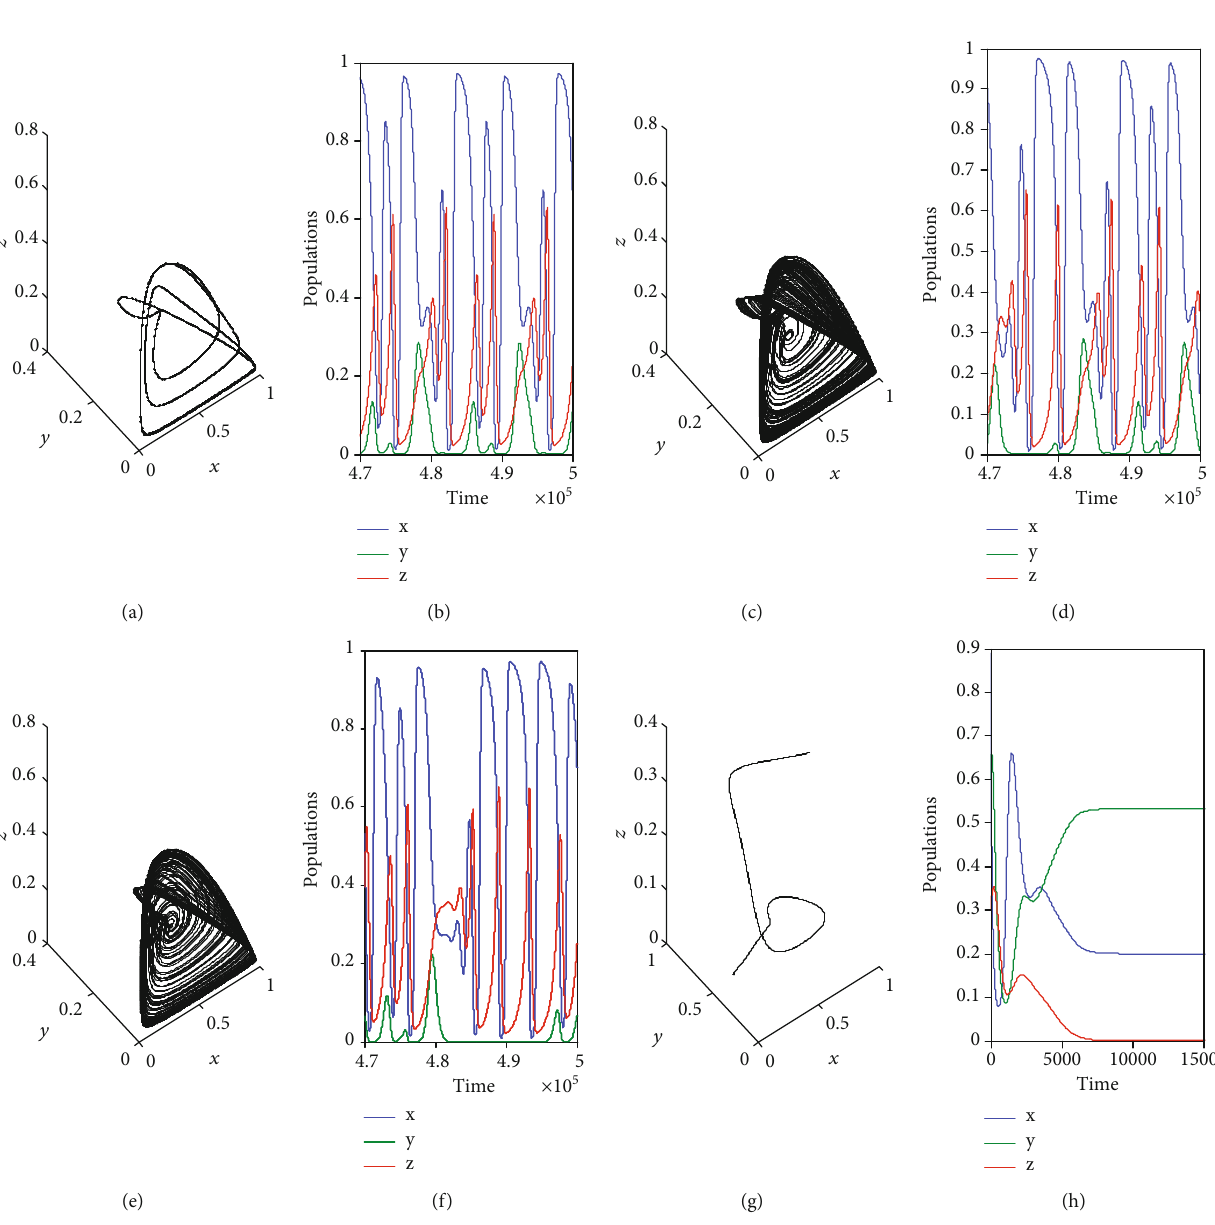
Figure 4: Trajectory of system (3) using the data given by Equation (87). (a) Period 3 in Int : ℝ 3 in (a). (c) Chaotic attractor in Int : ℝ 3 + where m = 0 : 026 . (d) Time series of attractor in (c). (e) Chaotic attractor in Int : ℝ 3 + where m = 0 : 06 . (f) Time series of attractor in (e). (g) Asymptotic stable PFEP in the xy -plane given by E 2 = ð 0 : 2, 0 : 53, 0 Þ where m = 0 : 15